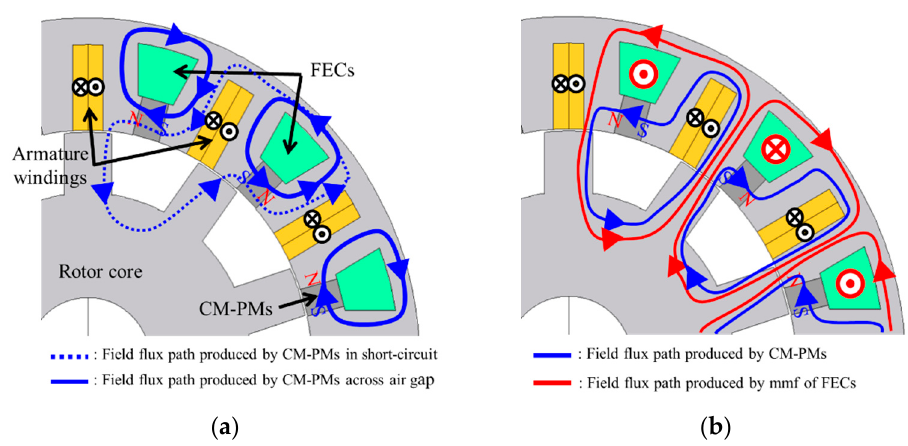
Figure 2. Field flux paths of the conventional HEFSM. ( a ) under no FEC excitation; ( b ) under FEC excitation.